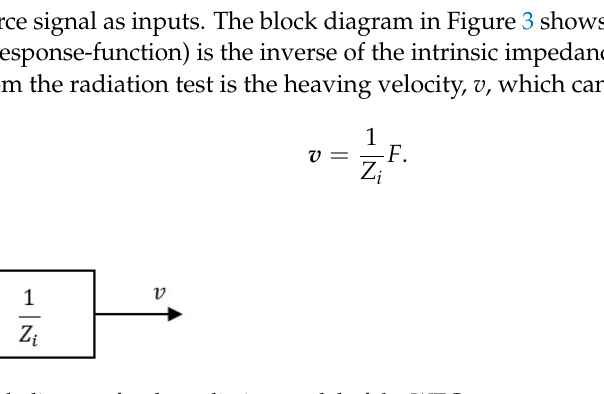
Figure 3. Block diagram for the radiation model of the WEC.